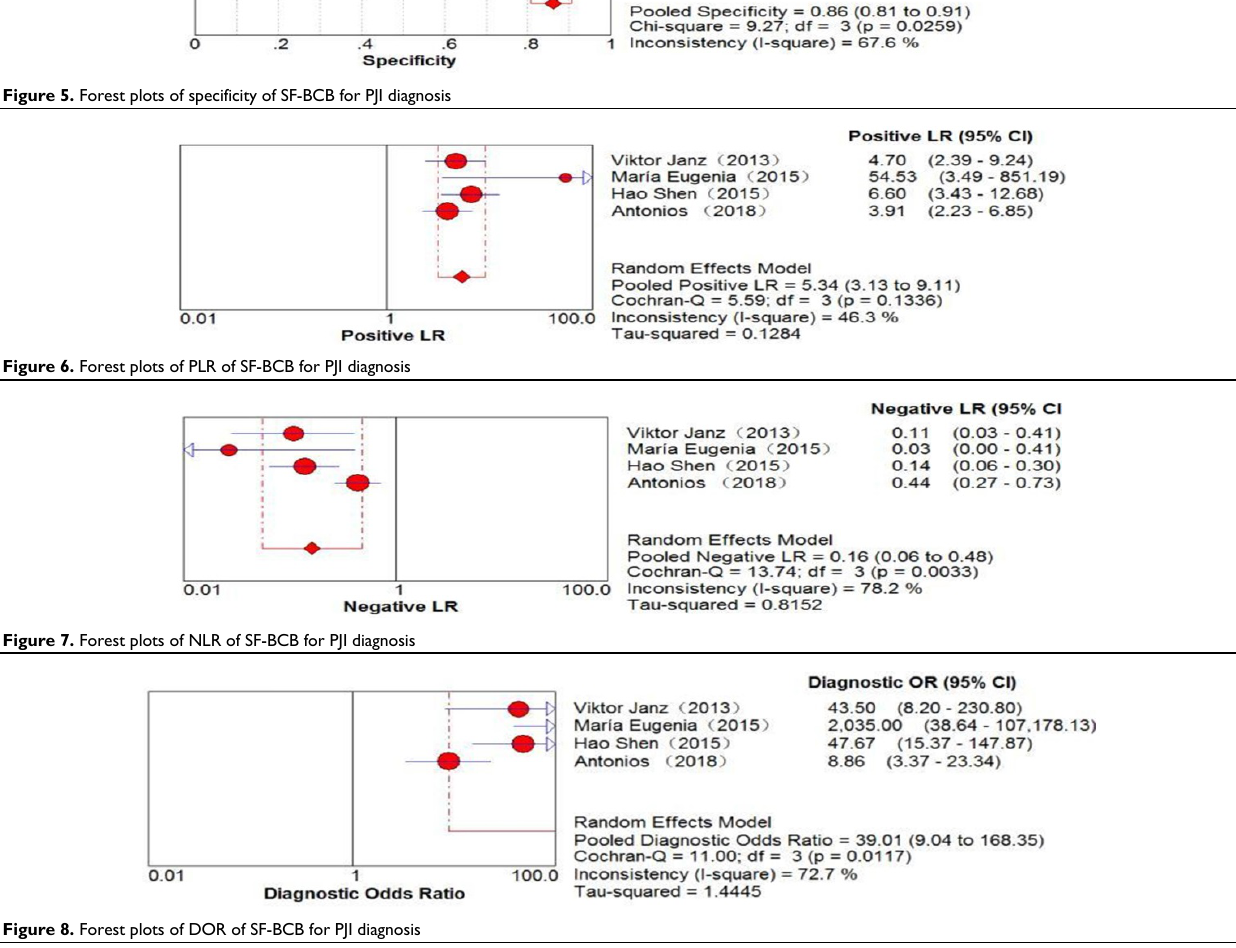
Figure 5. Forest plots of specificity of SF-BCB for PJI diagnosis